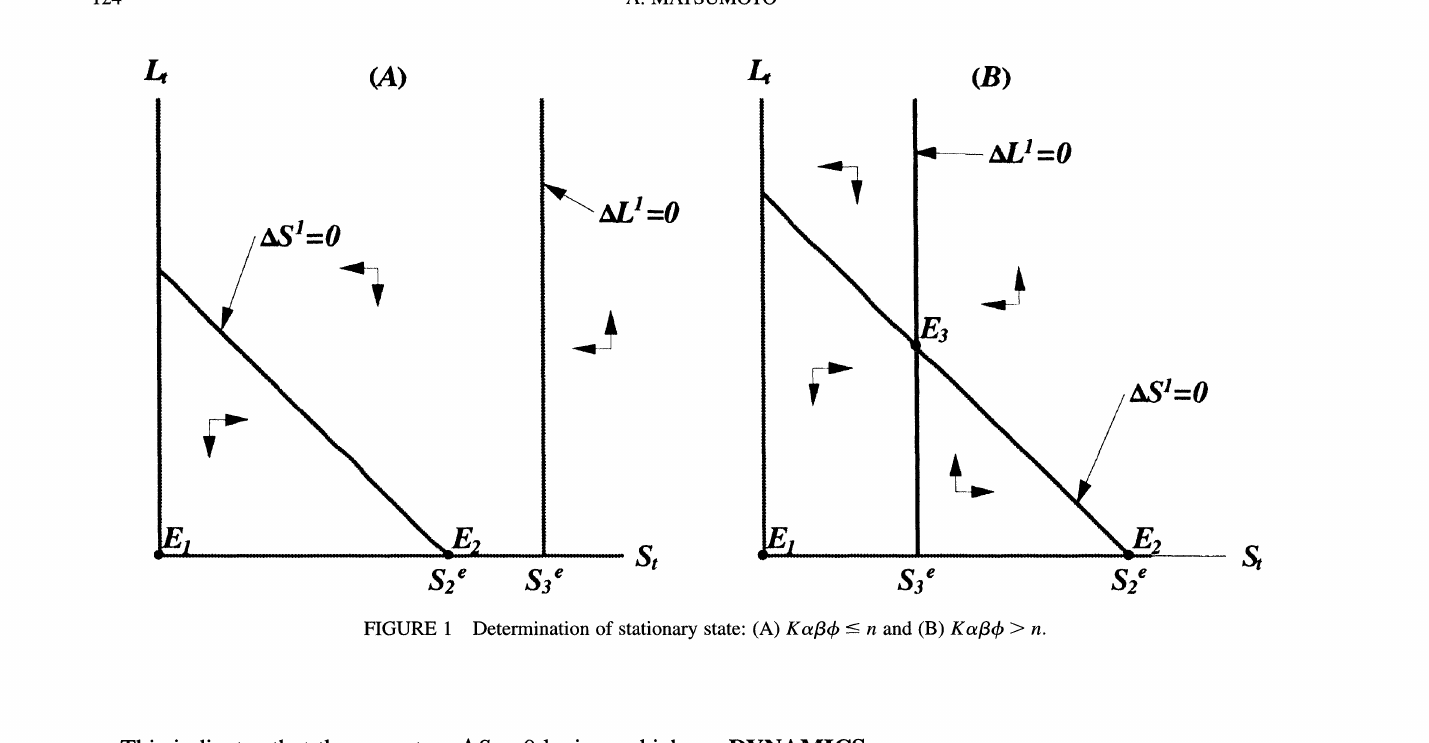
FIGURE Determination of stationary state: (A) Karl4) <-- n and (B) Karl4, >